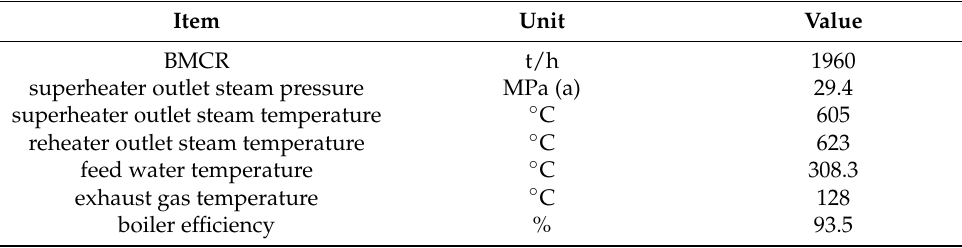
Table 2. Design operation parameters of the CFB